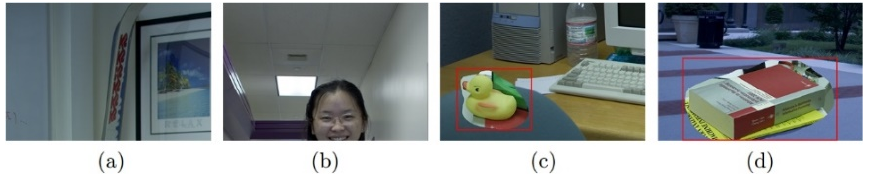
Figure 5. Examples of the images in Columbia dataset. ( a , b ) Untampered images; ( c , d ) tampered images.